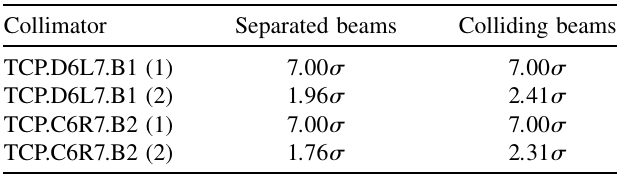
TABLE IV. The initial (1) and final (2) collimator jaw nominal half gaps in units of (cid:5) for the different scrapings. The beam centers determined in beam-based alignments in March 2012 and used during operation are assumed for the